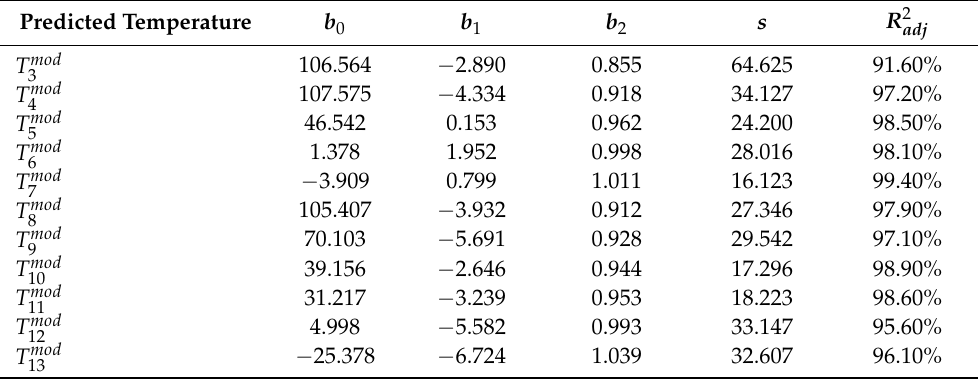
Table 6. Coefficients of modified regression models for channel temperatures and values of a multiple coefficient of determination and a standard error of the estimate (Source: own elaboration). Predicted